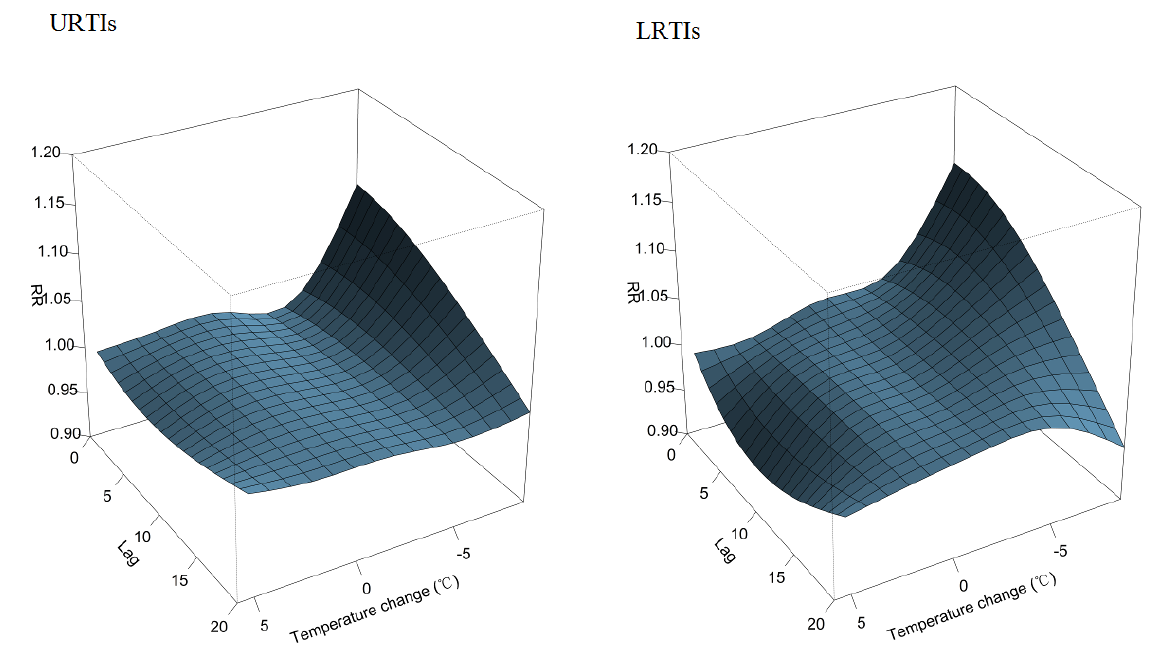
Figure 5. Relative risk of an outpatient visit for a respiratory tract infection (RTI) by temperature change (°C), days of lag, and RTI classification (upper RTIs (URTIs) and lower RTIs (LRTIs)). The reference value was 0 °C temperature